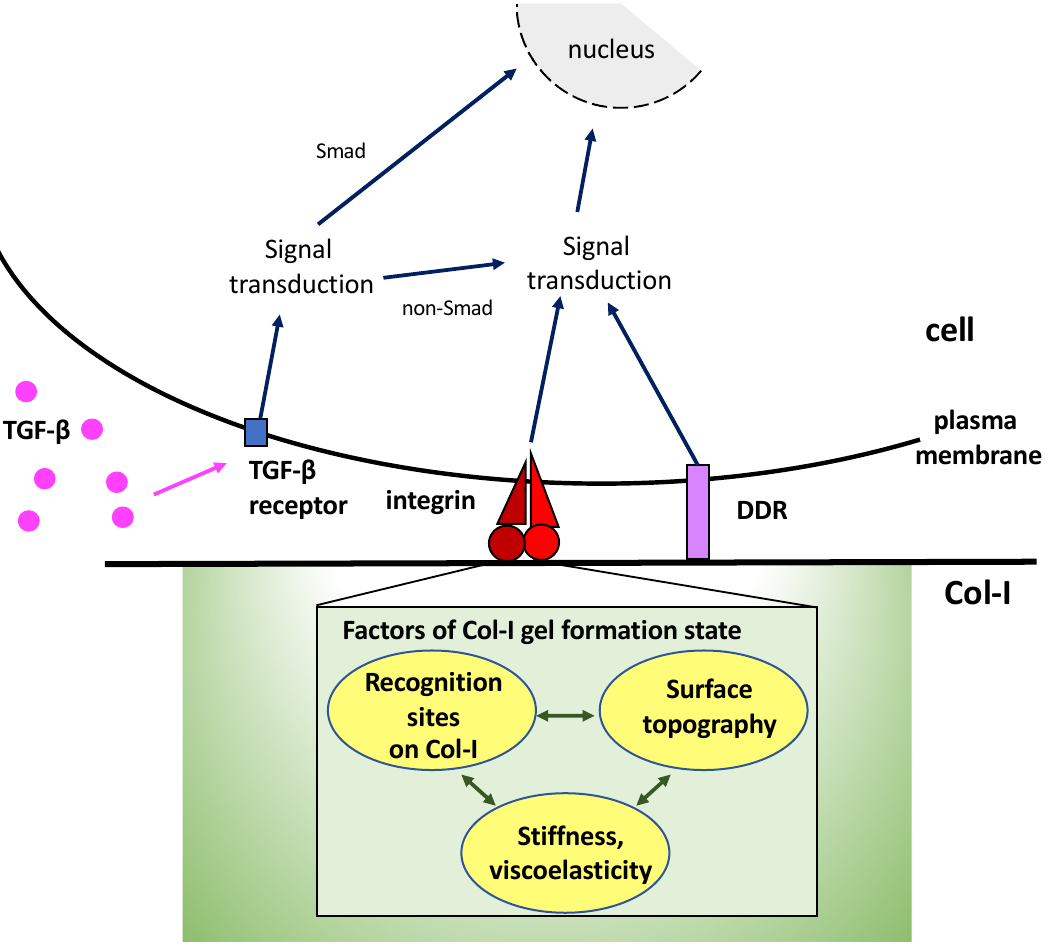
Figure 2. Effectors of integrin-mediated recognition on Col-I. Signaling activated by the recognition of Col-I substrates by integrins and DDR, as well as stimulation of soluble factors such as TGF- β , regulate cell behavior in concert. In addition, integrin-mediated signals are influenced by the factors on the gel-forming state of Col-I, such as the arrangement of cell recognition sites, surface topography, and